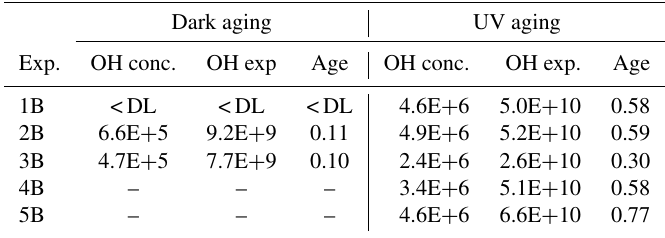
Table 4. Chemical ages (days) for the second set of chamber experiments (Exp. 1B–5B) and corresponding parameters: average OH concen- tration (moleccm − 3 ) and OH exposure (moleccm − 3 s) based on the decay of butanol-d9 (Barmet et al., 2012). The equivalent chemical age was calculated assuming an average atmospheric OH concentration of 1.0 × 10 6 moleculescm − 3